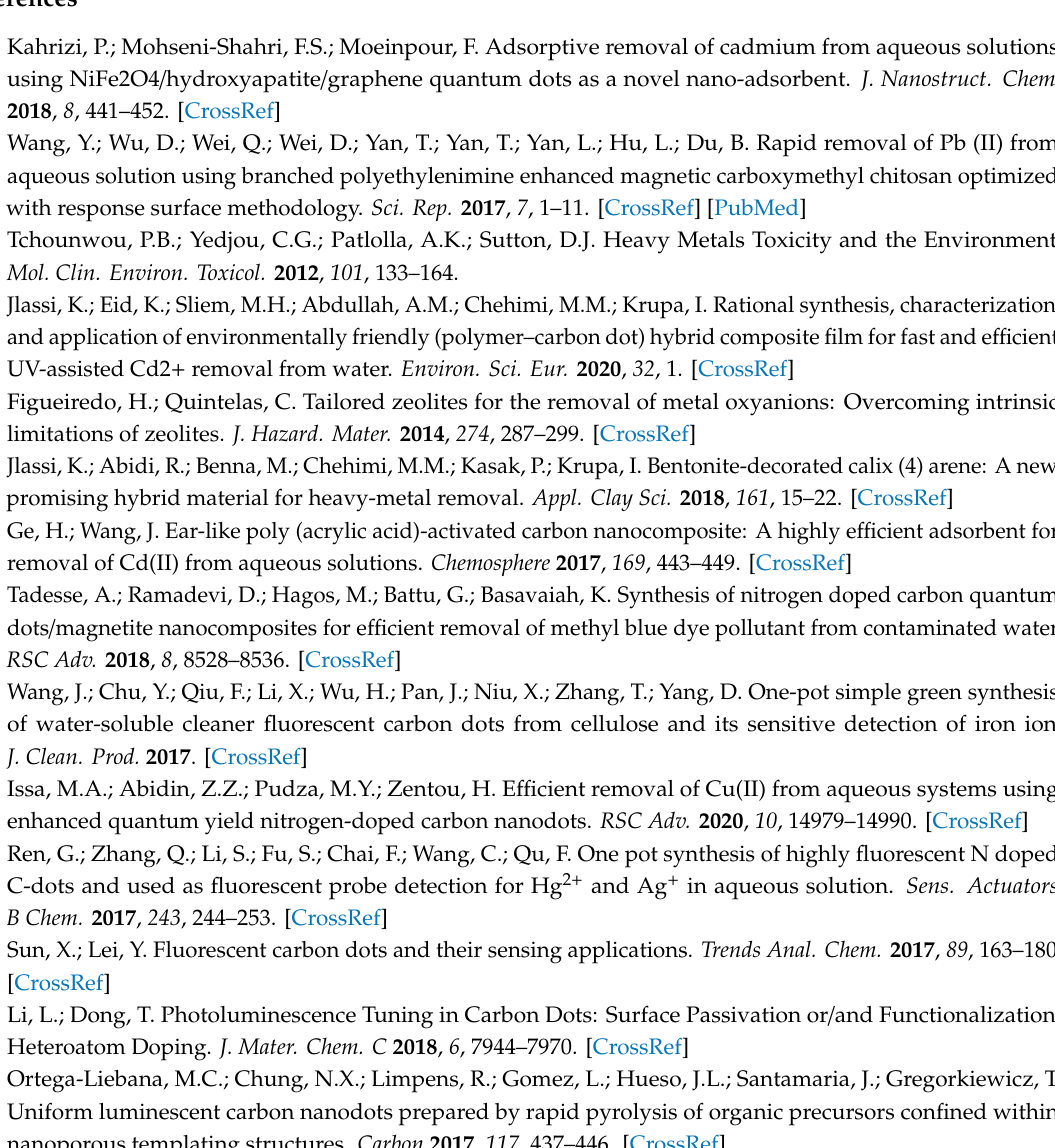
Supplementary Materials: The following are available online, Figure S1: Zeta potential of CDs, Figure S2: XPS spectrum of CMC, CDs and PVA-CDs, Figure S3: Photostability of PVA-CDs composite film at di ff erent aging times (a) and at di ff erent heating temperatures (b), Figure S4: Selectivity removal of Ni(II), Pb(II), Cd(II), Zn(II) and Hg(II) by using PVA-CDs composite film, Figure S5: Pseudo-first-order model (a) and Freundlich isotherm (b) for removal of Cd2 + onto PVA-CDs, Figure S6: (a) TEM image, (b) Zeta potential and (c) FTIR of PVA-CDs film in the presence of Cd2 + . Inset: size distribution, Table S1: Elemental compositions of the EFB, CDs and PVA-CDs samples by XPS